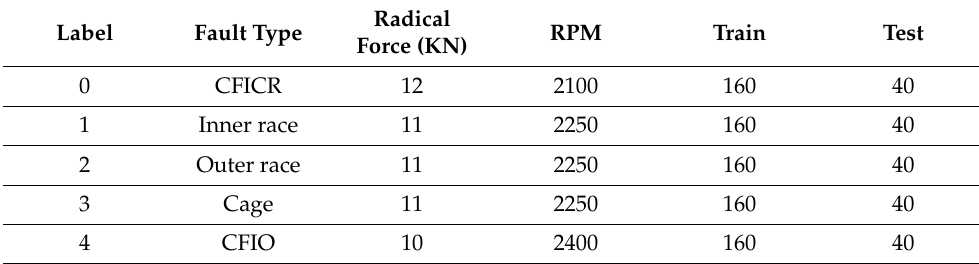
Figure 10. Visualization result of t-SNE dimensionality reduction. ( a – c ) are the t-SNE visualization results of the weighted data of the base sensor, FE sensor and DE sensor respectively, ( d – f ) are the t-SNE visualization results of the unweighted data, ( g ) is the t-SNE visualization result of the weighted data of all sensors. Table 5. Experimental datasets of